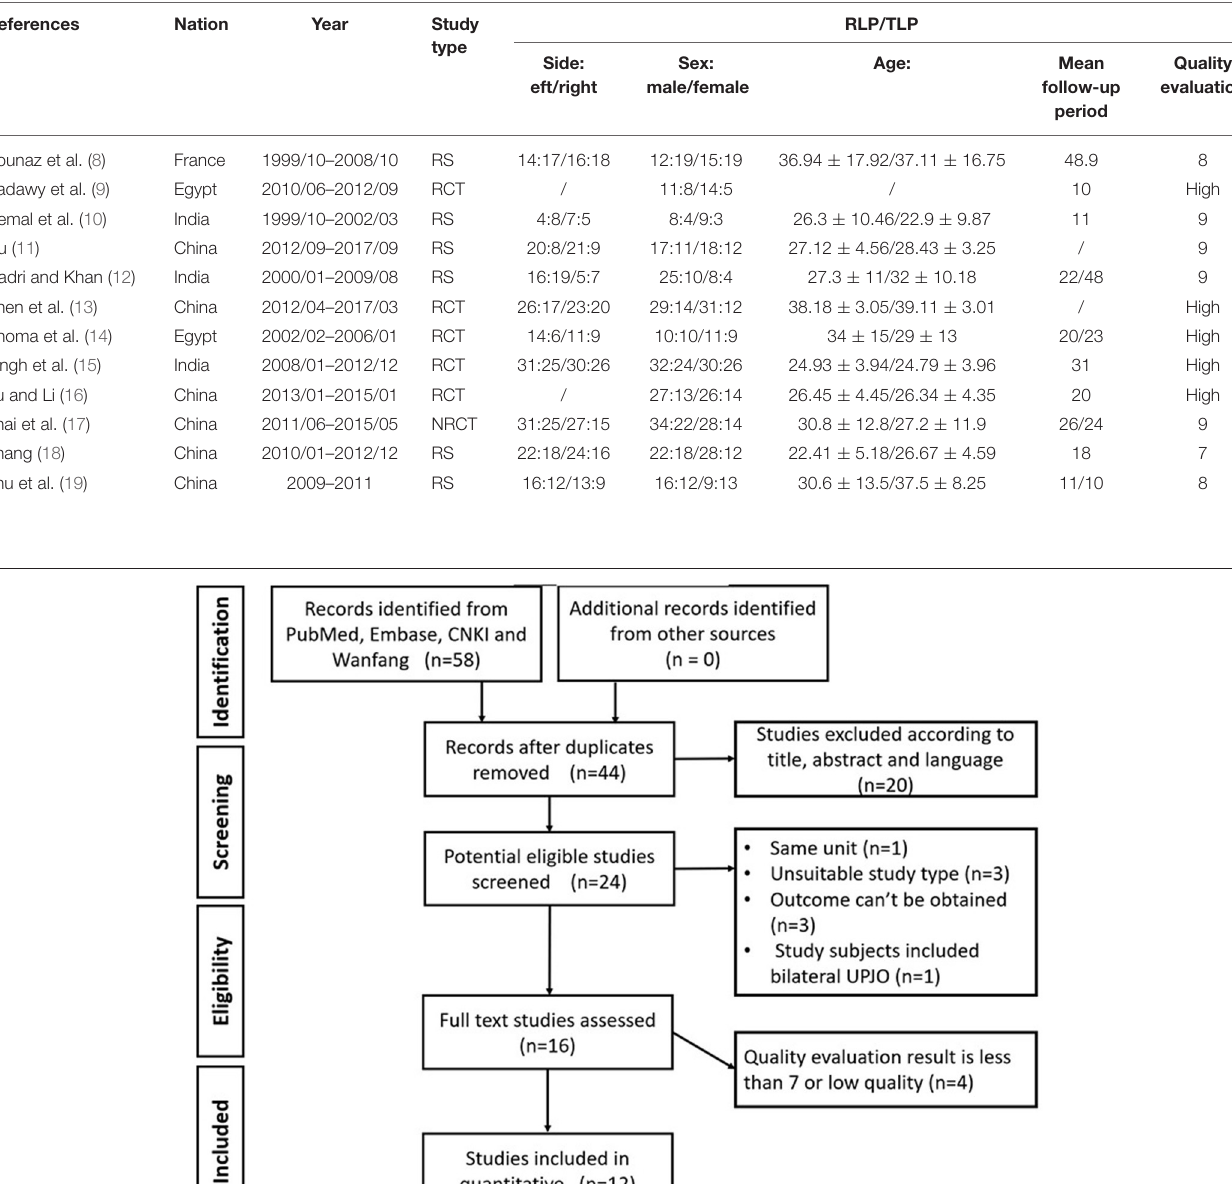
There were four studies that reported the VAS of the two